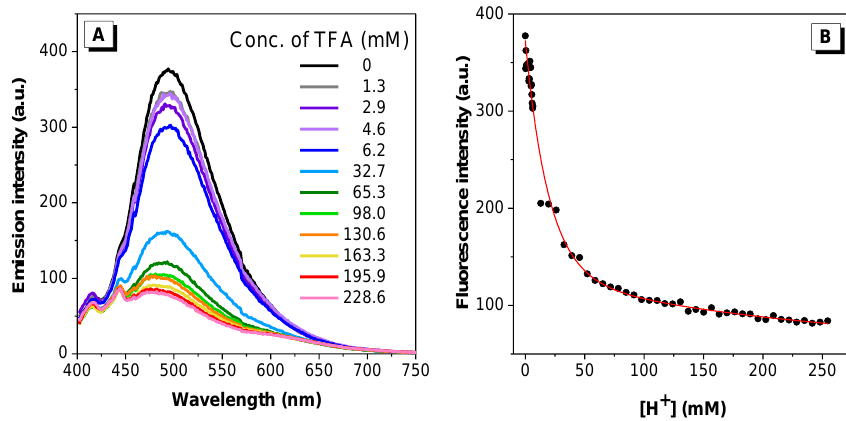
Figure 11. ( A ) Emission spectra of dye 2 in DMSO with increasing concentration of TFA. Dye concentration = 20 µM; λ ex: 392 nm; ( B ) emission intensity of dye 2 vs. proton concentration.